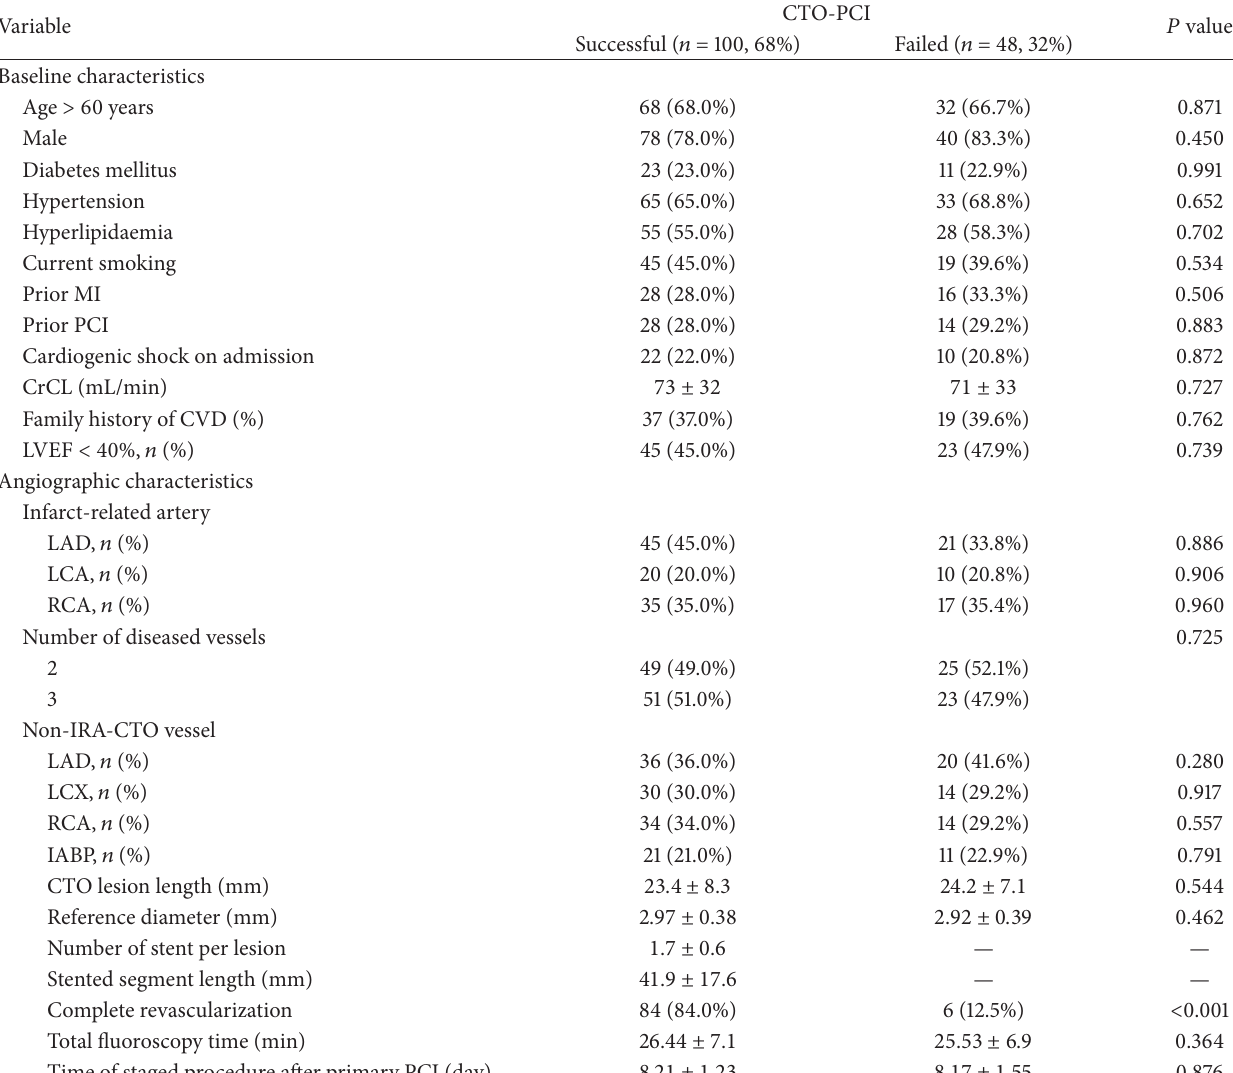
Table 2: Baseline clinical and angiographic characteristics of patients with CTO who underwent PCI attempt. Variable